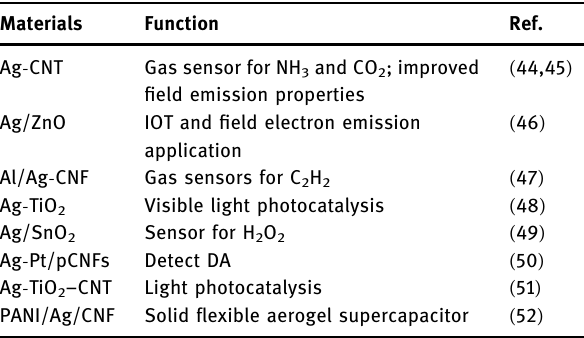
Table 1: Applications of Ag - loaded nanomaterials Materials